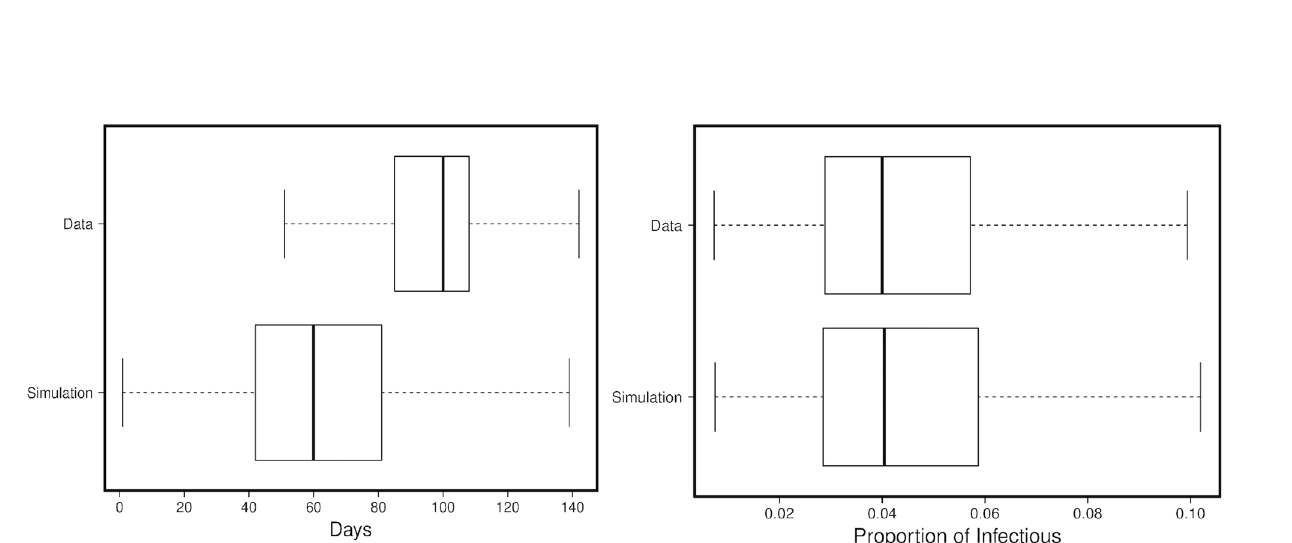
Fig 2. The distribution of diffusion speed (on the left) and peak load (on the right) for all zip-codes.